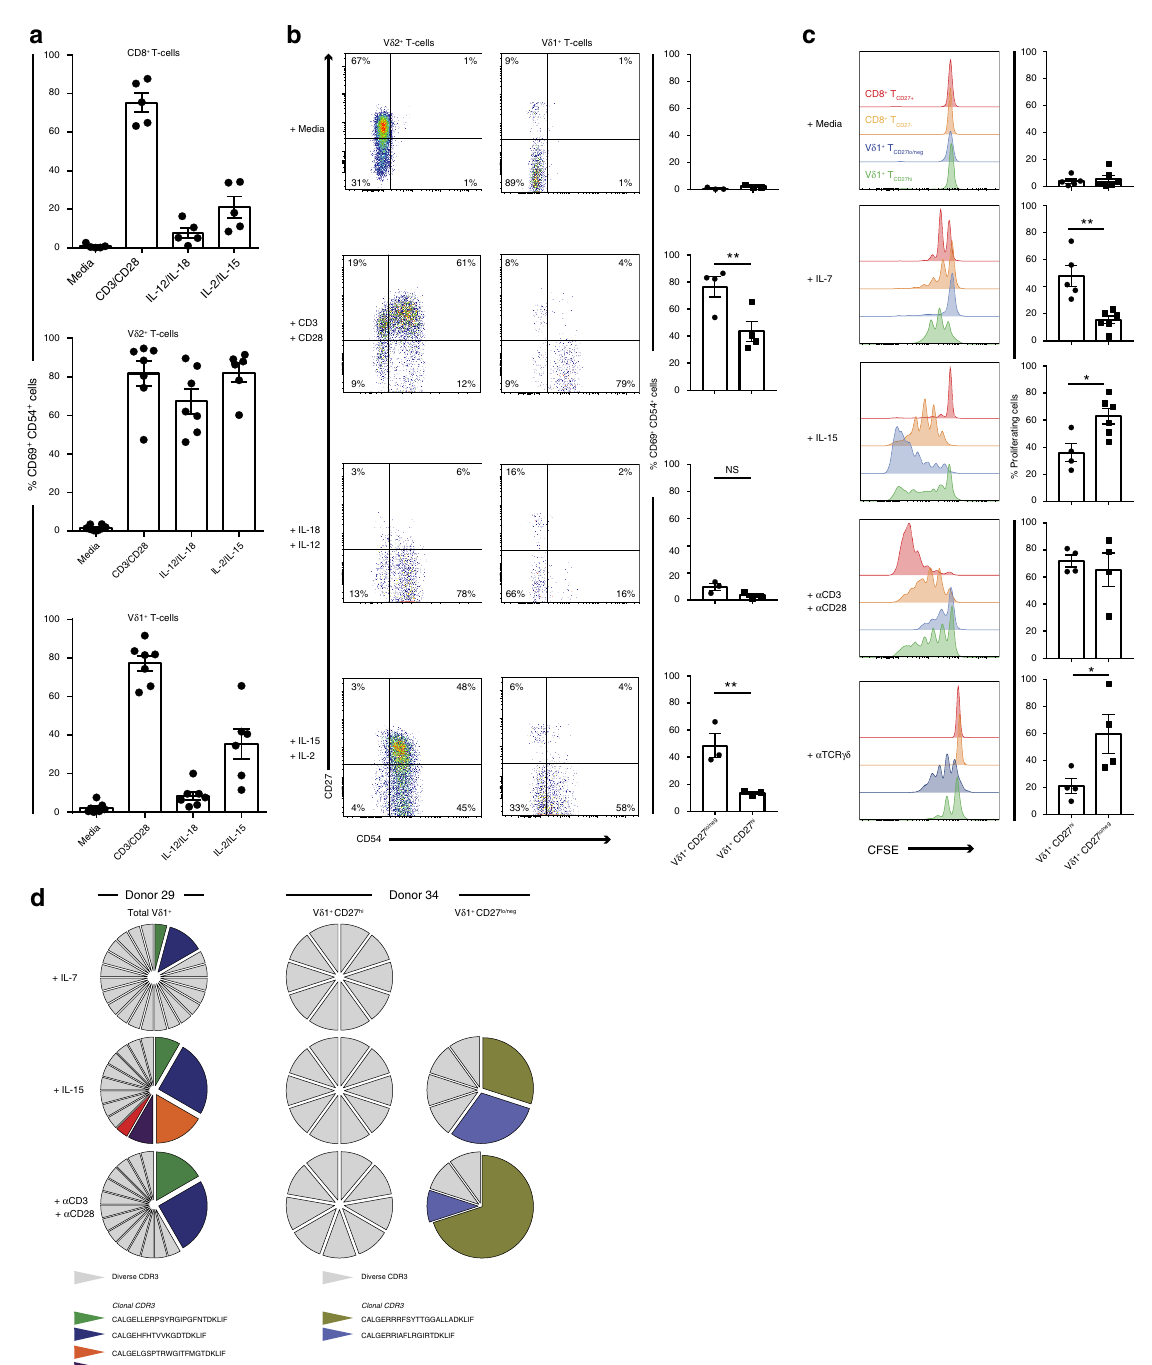
Figure 6 | Functional characteristics of clonally expanded CD27 lo/neg versus naive CD27 hi V d 1 þ Tcells. ( a ) Sorted CD3 þ Tcells were incubated for 72h with cytokines or anti-CD3/CD28 beads. CD8 þ , V d 2 þ and V d 1 þ Tcells were then assessed for the upregulation of CD69 and CD54. Graphs show mean ± s.e.m. from medium controls ( n ¼ 5–7), CD3/CD28 ( n ¼ 5–7), IL-12/IL-18 ( n ¼ 5–7) and IL-2/IL-15 ( n ¼ 5–6) stimulation. ( b ) Flow cytometry analysis of V d 2 and V d 1 Tcells from a , with cells analysed for CD27 and CD54 expression (left, representative flow cytometry plots) and graphs show mean ± s.e.m. of CD69 þ CD54 þ cells in V d 1 þ CD27 hi and V d 1 þ CD27 lo/neg populations, data from medium controls ( n ¼ 4), CD3/CD28 ( n ¼ 4), IL-12/IL-18 ( n ¼ 3) and IL-2/IL-15 ( n ¼ 3). ( c ) Proliferation of V d 1 Tcells, assessed by CFSE dilution, for 7 days in response to stimulation with IL-7, IL-15, anti-CD3/CD28 and anti- TCR gd mAb. Histograms are from a representative focused adult donor’s V d 1 þ CD27 hi cells, V d 1 þ CD27 lo/neg cells, CD8 þ CD27 þ or CD8 þ CD27 neg T cells and graphs show mean ± s.e.m. of proliferating cells ( n ¼ 4–6). ( d ) Total proliferating V d 1 þ Tcells (Left, donor 29) or CD27 hi and CD27 lo/neg V d 1 þ T cells were single cell sorted and CDR3 d sequenced by PCR, prevalent clonotypes detected by previous deep sequencing are coloured and diverse individual sequences are grey. Donor 29 had 24 single cells, and donor 34 had 10 single cells analysed from each condition. Data analysed by student’s t test, NS ¼ P 4 0.05, * P o 0.05 and ** P o 0.01.